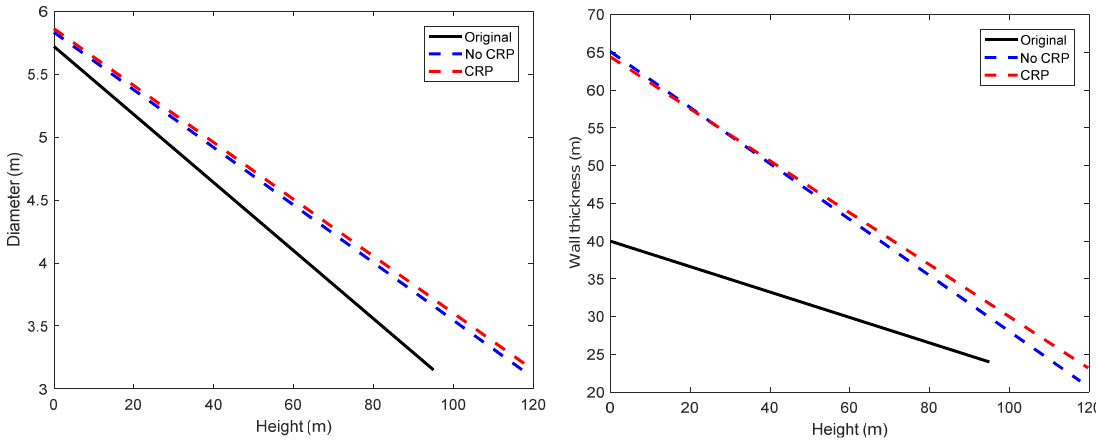
Figure 18. Tower outer diameter and wall thickness distributions of the baseline and the optimized towers. Table 6. Optimization design results of the